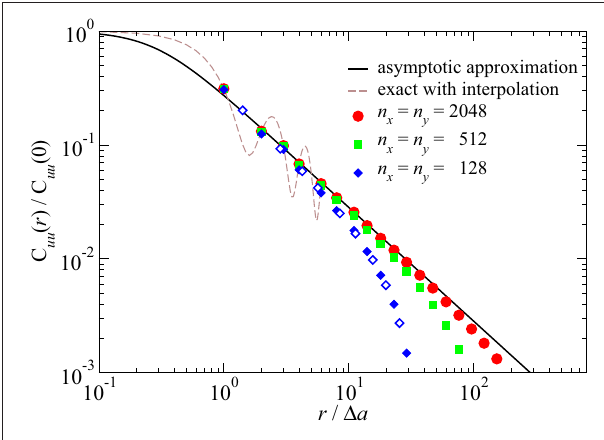
FIGURE 2 | The radial displacement ACF C uu ( r )—normalized to its value at r 0—as a function of distance r : asymptotic approximation given in = Equation (27) (black line), exact correlation function along the [10] direction with interpolation between non-lattice sites (dashed brown line), numerically exact results for systems of size 2,048 2,048 (red circles), 512 512 (green × × squares), and 128 128 (blue diamonds). They were also obtained for the [10] × direction, except for the open symbols, which refer to the [11]